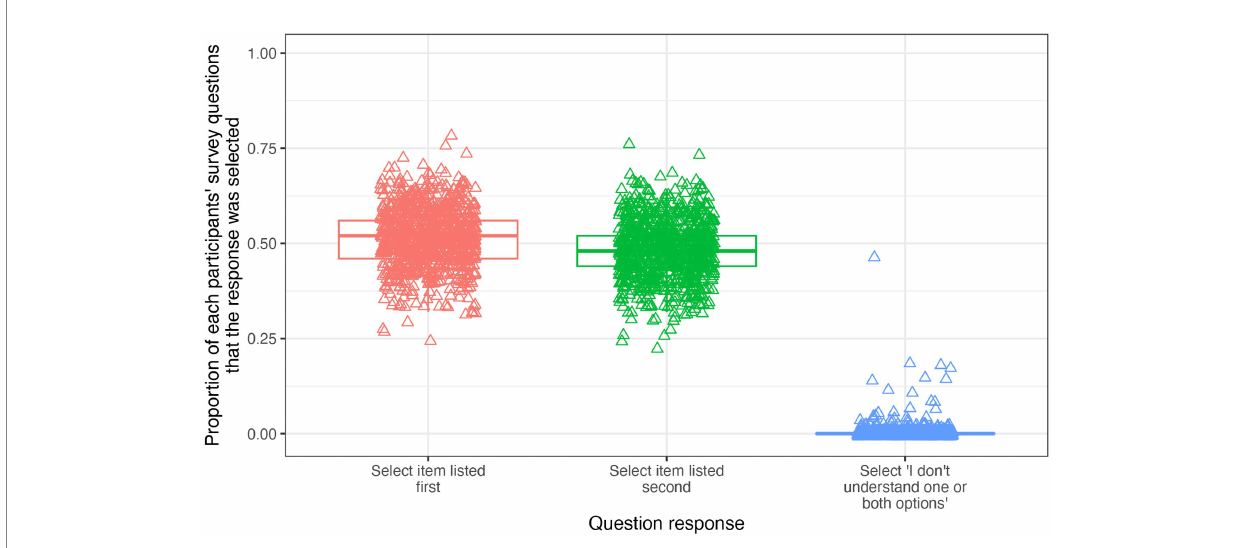
FIGURE 3 A chart to demonstrate the proportion of questions each response was selected by each survey participant. There are three box plots, one for each possible response in a pairwise comparison: selecting the item listed first, selecting item listed second or selecting “I do not understand one or both of the